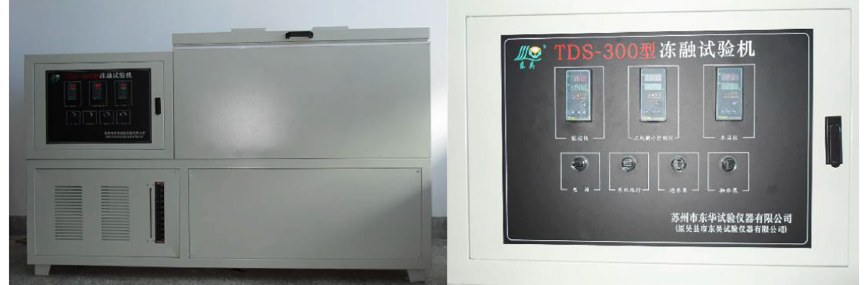
Figure 3: Experimental apparatus of TDS-300 periodic freeze-thaw cycles.